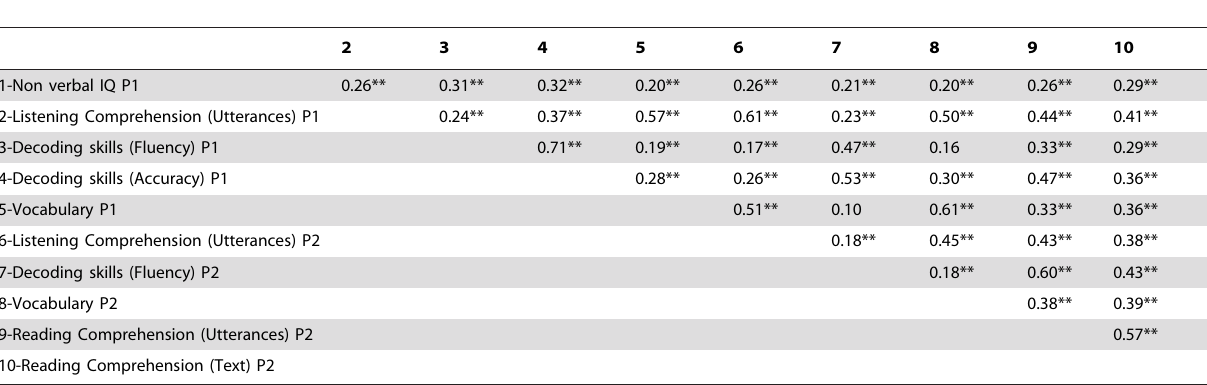
Table 2. Correlation matrix between all